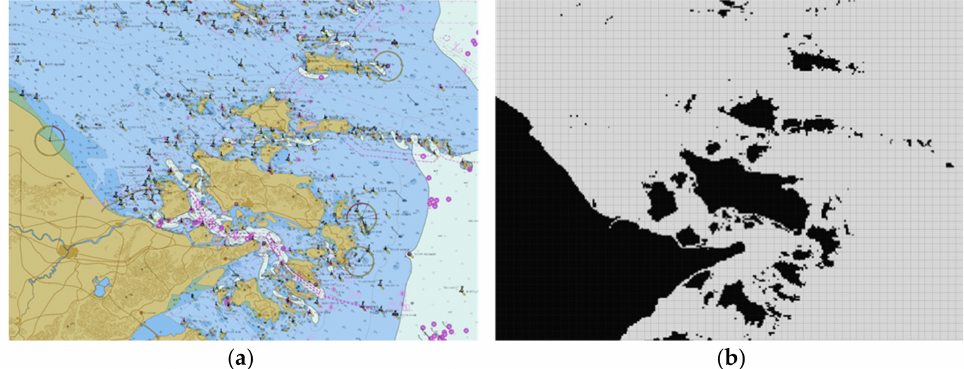
Figure 3. S-57 environment modeling map. ( a ) S-57 ENC of the study area; ( b ) Grid navigation environment